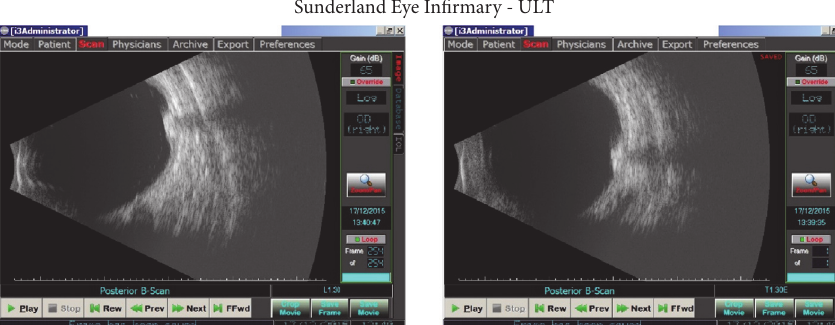
Figure 4: A B-scan report of the astrocytoma revealing calcification and high reflectivity. Impression: solid elevated mass SN equator. Patchy high reflectivity centrally persisting at low gain and with posterior shadowing in keeping with calcification. Lower reflectivity posterior and superior edges. No retinal detachment. PVD appears complete. Appearance in keeping with